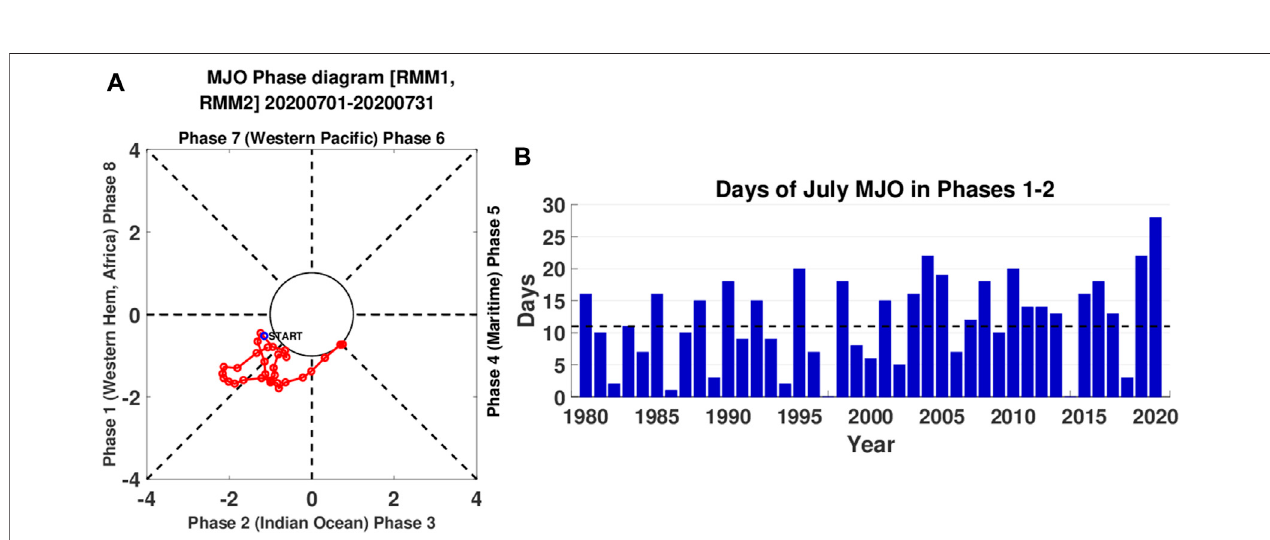
FIGURE 11| (A) RMM index phase – spacediagram in July 2020. (B) Days ofthe July MJO in Phases 1 – 2during 1980 – 2020. The average ofthe days isshown by the black dotted line.